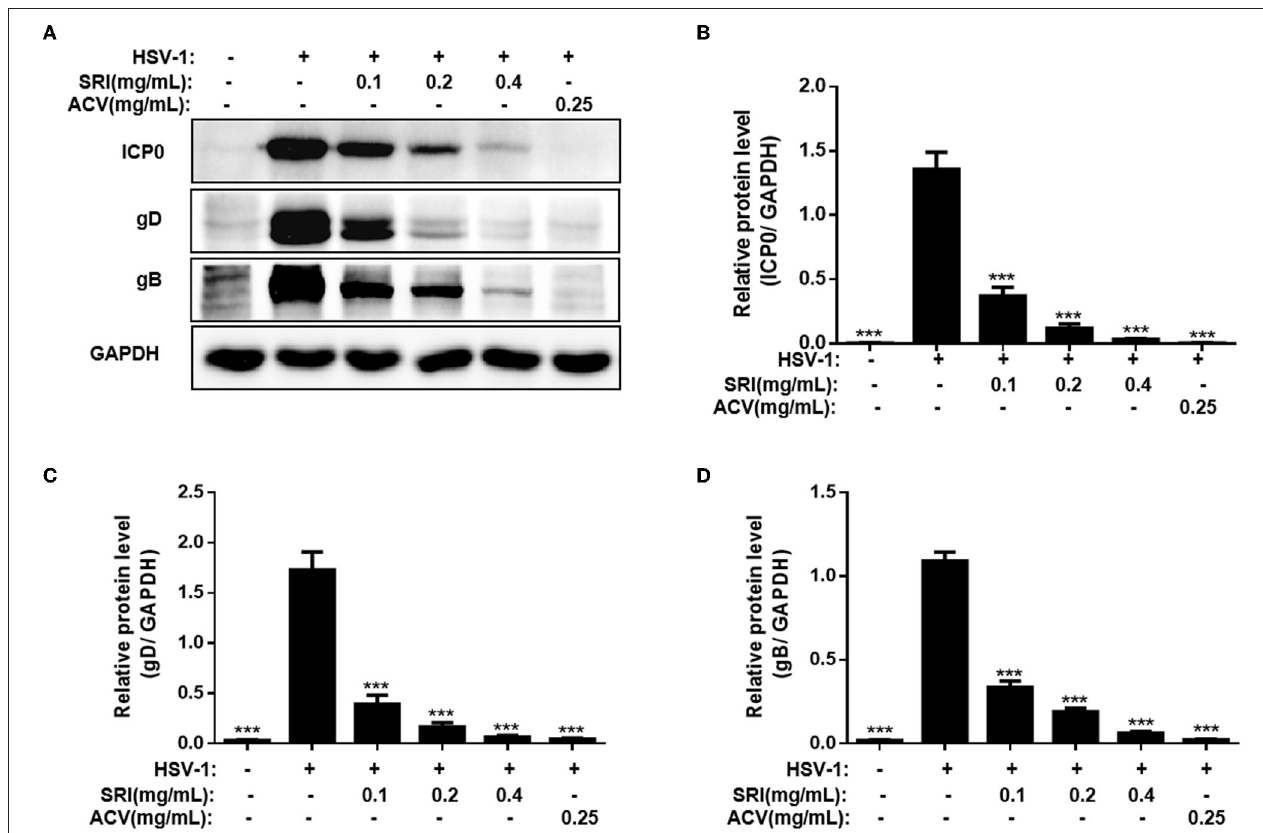
FIGURE 5 | SRI inhibited the HSV-1 ICP0, gB, and gD protein expression levels. (A–D) Cells grown in six-well plate were infected with HSV-1 and treated with SRI (0.05, 0.1, 0.2, and 0.4 mg/mL) or ACV (0.25 mg/mL). At 24h post-infection, the cellular proteins were harvested and determined using Western blot analysis using primary antibodies to HSV-1 ICP0, gB, gD, and GAPDH. GAPDH was used as a standard loading control. The quantification results of the Western blot analysis of ICP0 (B) , gD (C) , and gB (D) . The data are expressed as mean ± SD. *** p < 0.001, vs. HSV-1